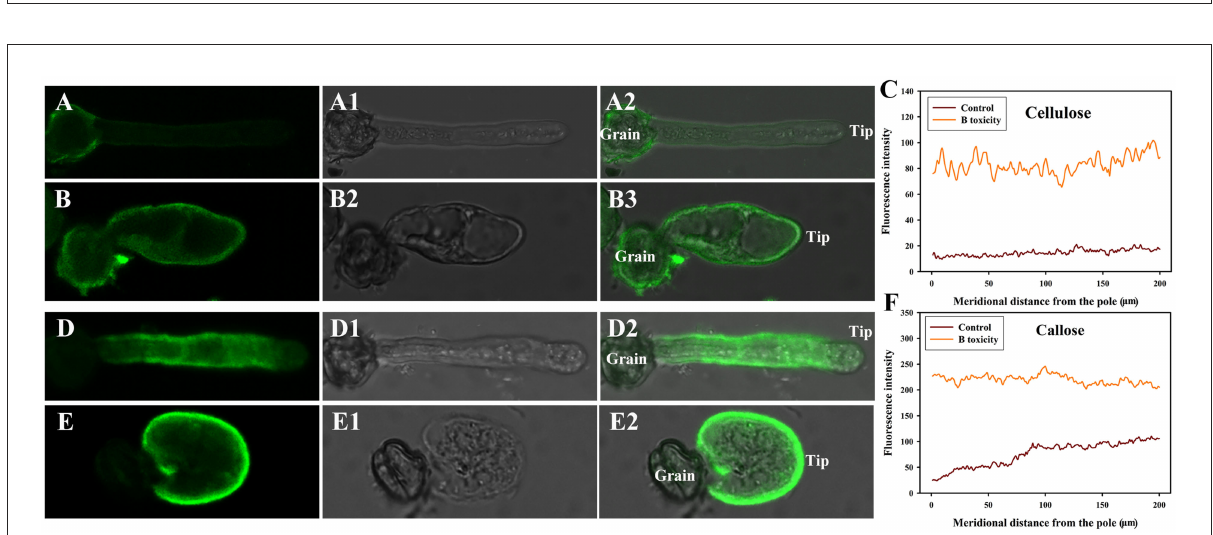
FIGURE3 Effects of B on cellulose and callose distribution on C . mollissima pollen tube wall. (A) Cellulose in control pollen tube indicated by CBM3a labeling. (B) Cellulose in B toxicity-treated pollen tube. (C) Quantitative analysis of the fluorescent intensity of cellulose in the wall of control and B toxicity-treated pollen tubes. (D) Callose in control pollen tube indicated by monoclonal antibody to (1 → 3)- β -glucan labeling. (E) Callose in B toxicity-treated pollen tube. (F) Quantitative analysis of callose fluorescent intensity in the wall of control and B toxicity-treated pollen tubes. Bar = 10 µ